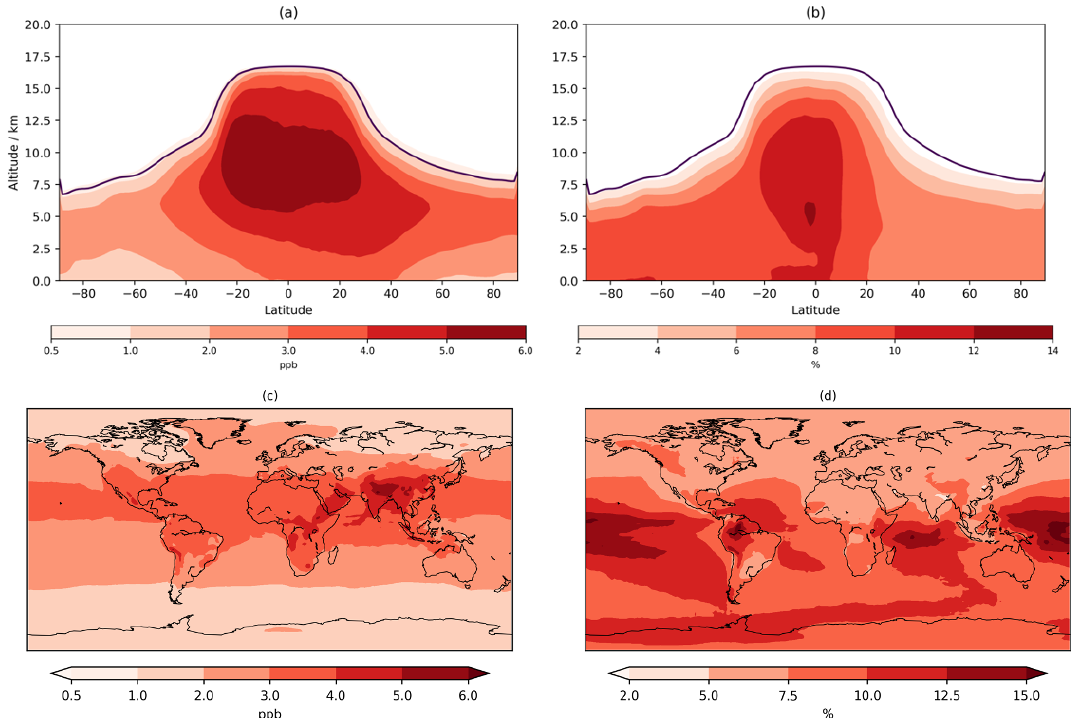
Figure 4. Annual mean tropospheric zonal (a, b) and lowest 500m (c, d) change in O 3 mixing ratio (CS2/CS). Purple line in the zonal mean shows the average height of the